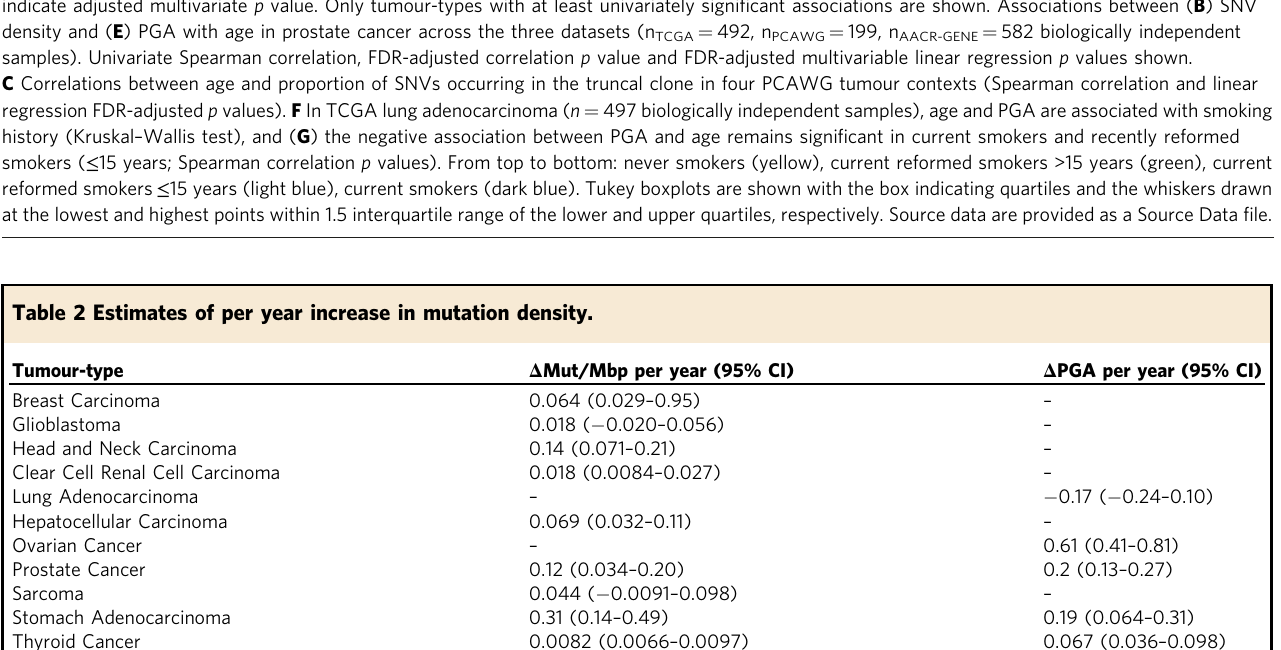
Fig. 1 Mutation density and timing are associated with age at diagnosis. Summary of associations between age and ( A ) SNV density and ( D ) percent genome altered (PGA) in TCGA, PCAWG and AACR GENIE tumours. The dot size and colour show the Spearman correlation, and background shading indicate adjusted multivariate p value. Only tumour-types with at least univariately signi fi cant associations are shown. Associations between ( B ) SNV density and ( E ) PGA with age in prostate cancer across the three datasets (n TCGA = 492, n PCAWG = 199, n AACR-GENE = 582 biologically independent samples). Univariate Spearman correlation, FDR-adjusted correlation p value and FDR-adjusted multivariable linear regression p values shown. C Correlations between age and proportion of SNVs occurring in the truncal clone in four PCAWG tumour contexts (Spearman correlation and linear regression FDR-adjusted p values). F In TCGA lung adenocarcinoma ( n = 497 biologically independent samples), age and PGA are associated with